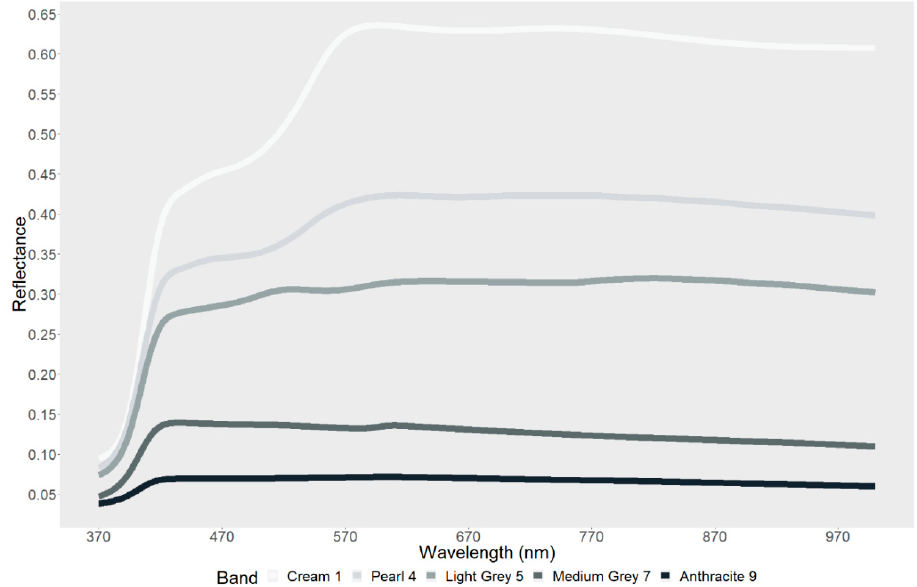
Figure 6. The reflectance of targets used in the field experiment measured by StellarNet BlueWAVE field spectrometer directly before flight. field spectrometer directly before